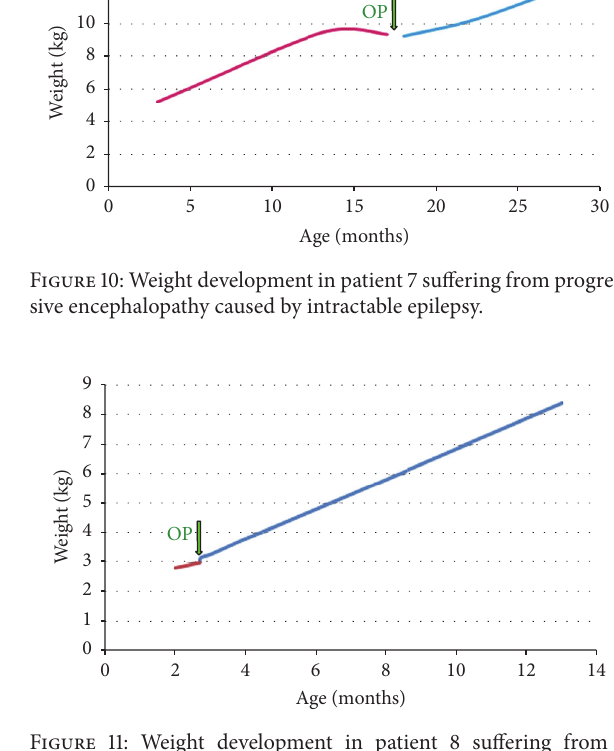
Figure 11: Weight development in patient 8 suffering from a microdeletion22q11syndromicdisorderwithcardiacmalformation. After 3 months of RJFT use, the tube was removed, and the girl continued to grow well on oral feeding, with a weight for age at the 30th